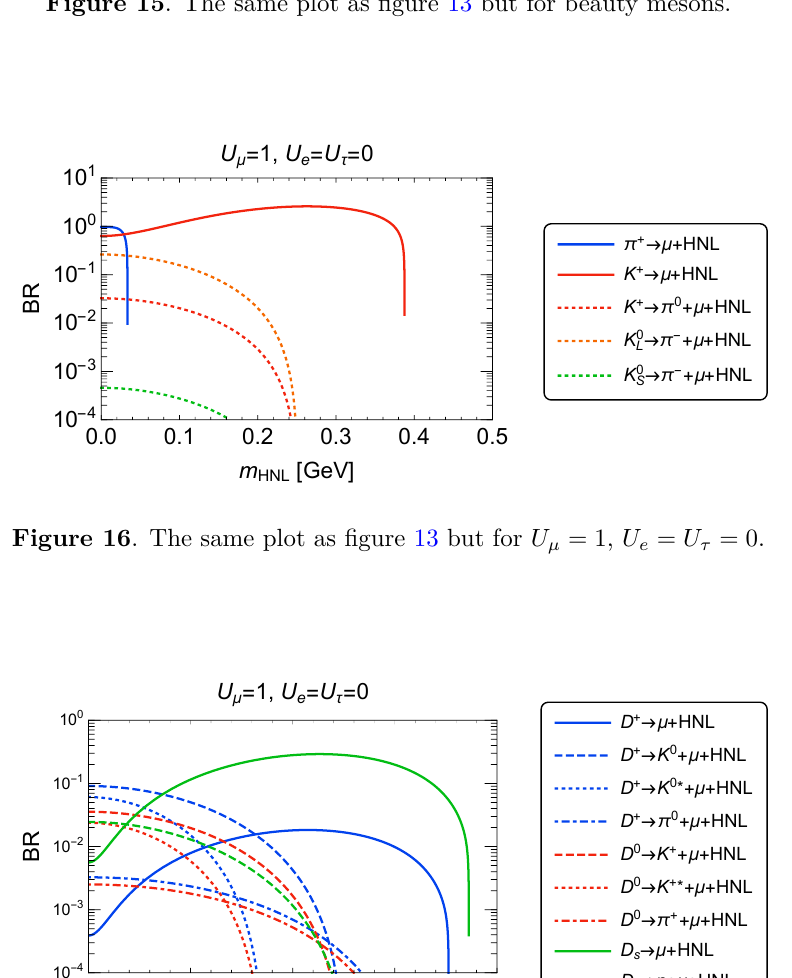
Figure 15 . The same plot as figure 13 but for beauty mesons.